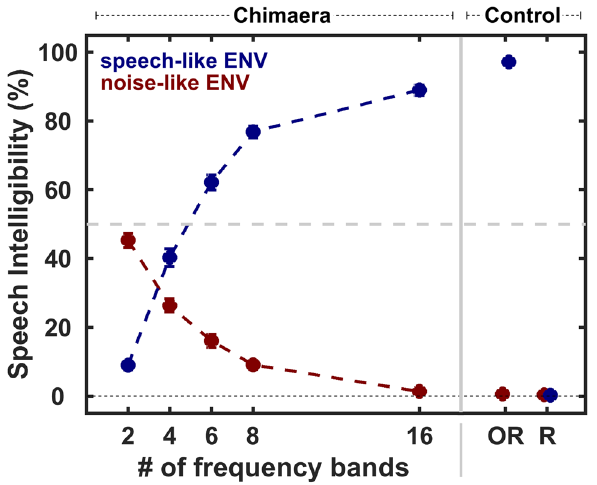
Figure 1. Speech intelligibility across conditions for each ENV type. Speech intelligibility (mean ± sem) was measured as a function of chimaera and control conditions, with stimulus ENV type indicated by color. As the number of frequency bands increased, intelligibility of sound content increased for chimaera with a speech- like ENV (blue), but decreased for chimaera with a noise-like ENV (red). During control conditions, listener’s performance on sound content intelligibility reached ceiling levels for original speech (OR S ), but floor levels for SMN (OR SMN ) and both reversed control stimuli (R S /R SMN ).